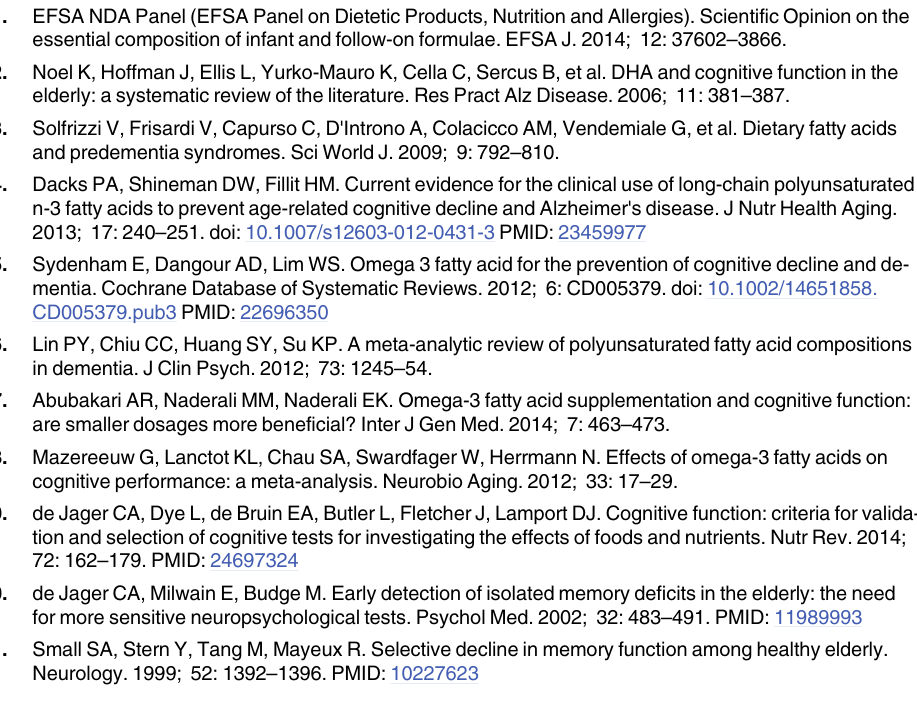
S1 Table. Memory Types Assigned to Outcomes in Published Studies. S2 Table. Characteristics of Observational Studies Reporting DHA/EPA Status and Memo- ry Outcomes. S3 Table. Summary of DHA/EPA Supplementation and Semantic Memory Outcomes in Adults. S4 Table. Summary of DHA/EPA Supplementation and Working Memory Outcomes in